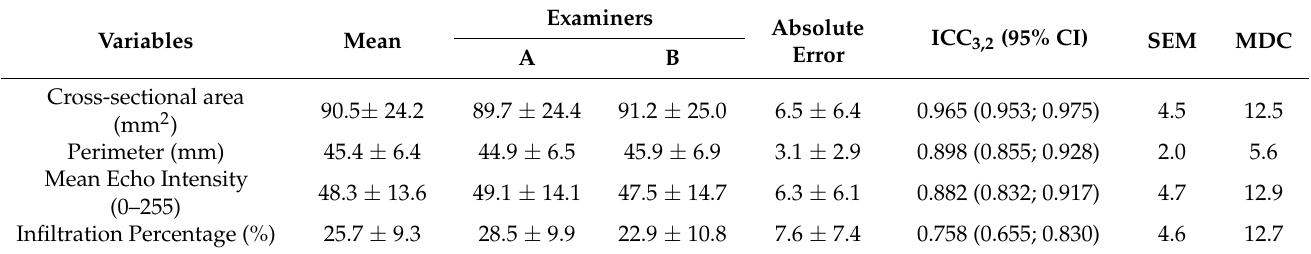
Table 2. Interexaminer reliability analysis for cervical multifidus ultrasound measurements.